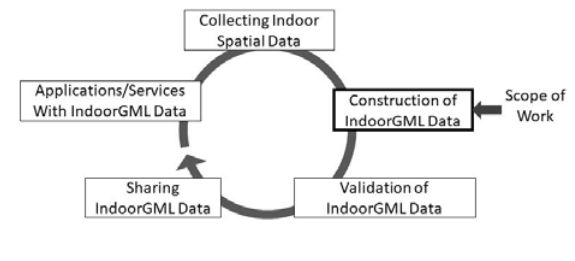
Figure 2. The Eco-System of IndoorGML